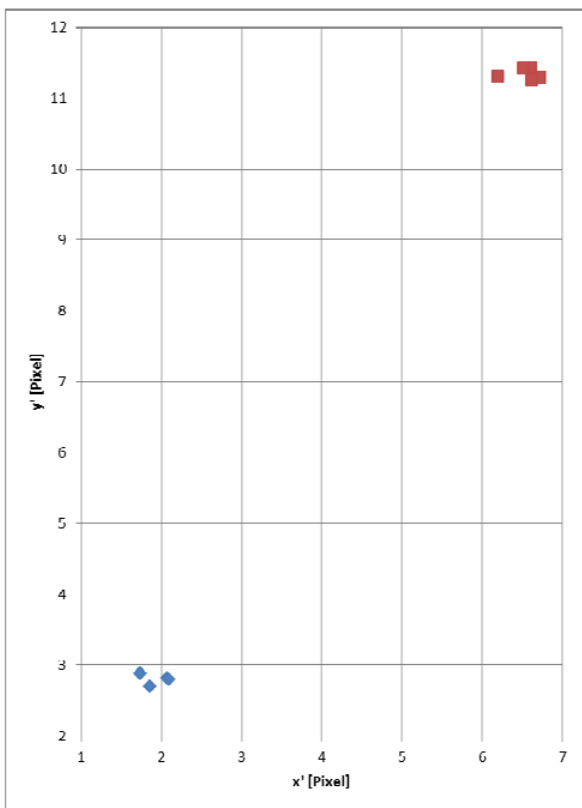
Figure 7. Calibration results for principal point of the RGB camera (blue) and the IR camera (red)